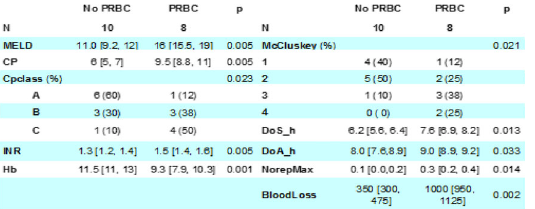
Table 2 (abstract 000728). Factors associated with PRBC transfusions T1